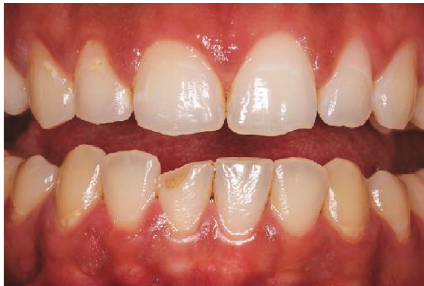
Figure 4: Patient simulating nail